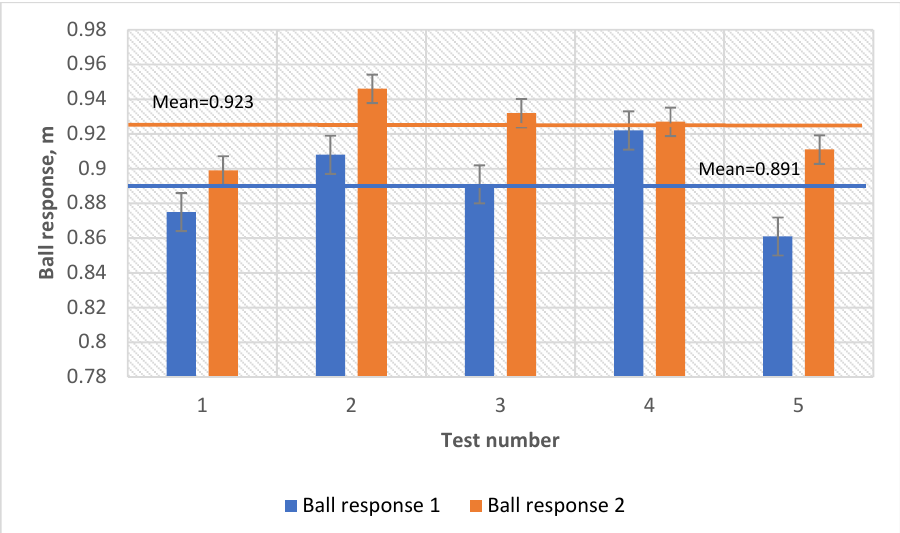
Figure 9. Ball response in the case of the type A basket surface with three long strips (Ball response 1) and five longitudinale strips (Ball response 2).